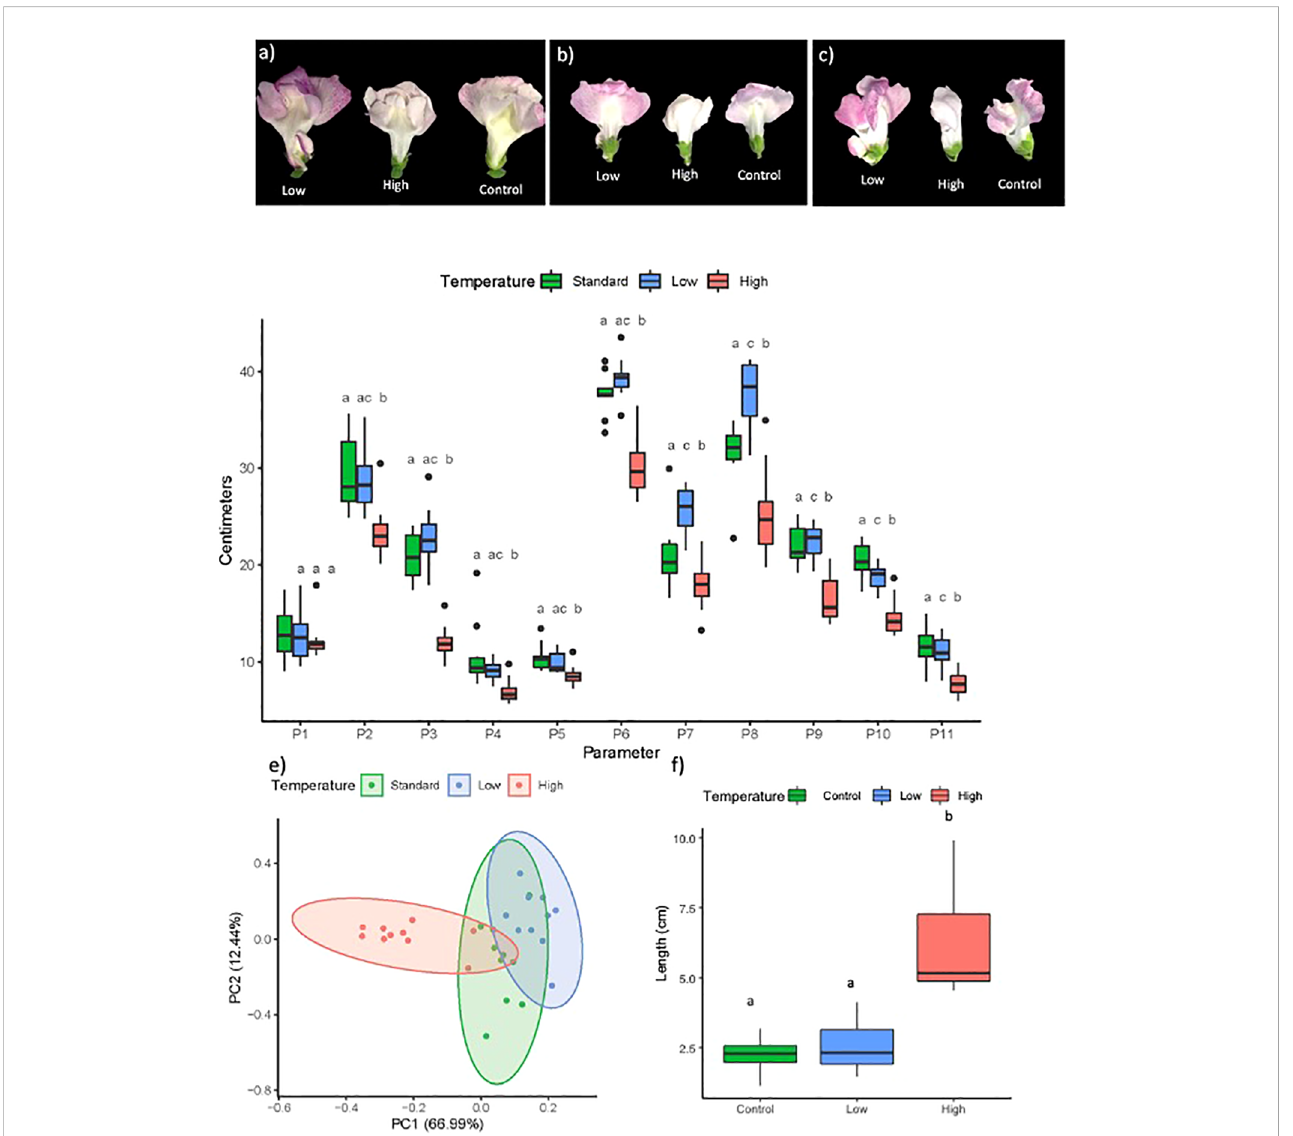
sepal length; P5: tube width; P6: upper petal length: P7: lower petal expansion; P8: upper petal expansion: P9: stamen length: P10: gynoecium length: P11: pallate expansion. Different letters for each parameter indicate signi fi cant differences according to Fisher's F test or Wilcoxon test (see